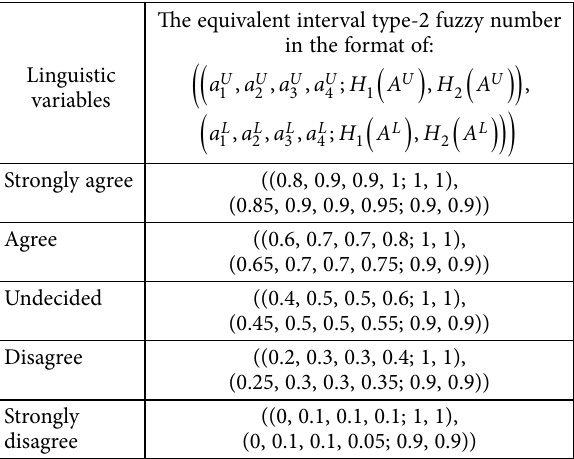
Table 3. The scale used in data gathering The equivalent interval type-2 fuzzy number in the format